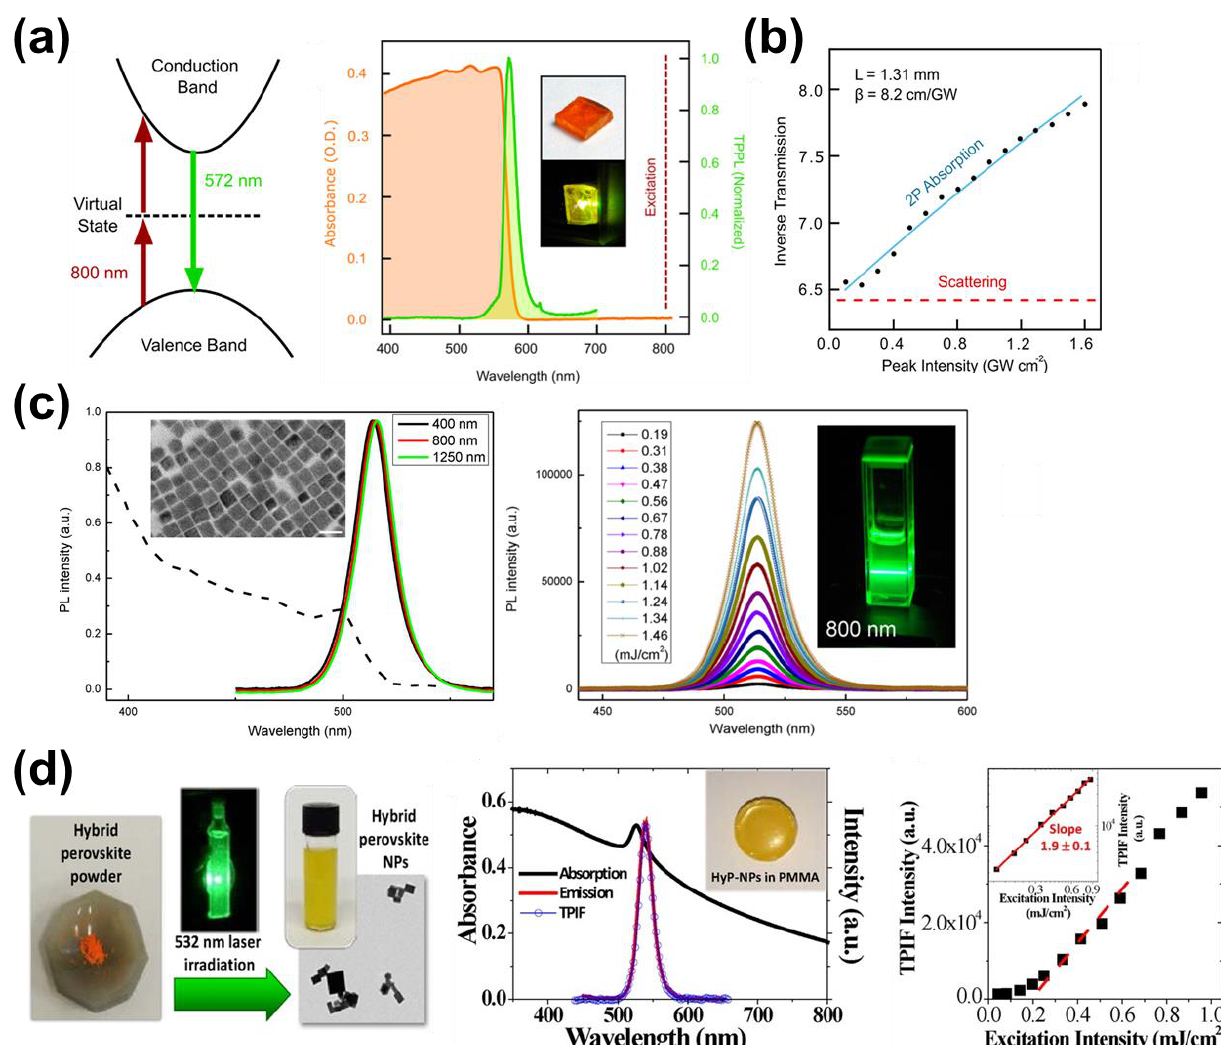
Figure 18. ( a ) Schematic showing two-photon absorption of 800 nm light and up-conversion to 572 nm photoluminescence and a linear optical absorbance and normalized two-photon-induced photoluminescence as a function of wavelength for a single MAPbBr 3 crystal. [96]. Copyright 2015 American Chemical Society. ( b ) The two-photon absorption coefficient of inverse transmission versus peak intensity. [96]. Copyright 2015 American Chemical Society. ( c ) The linear absorption spectrum and one-, two-, and three-photon excited PL spectra from the solution of CsPbBr 3 NCs and the excitation intensity-dependent PL showed the photograph of the resolution of CsPbBr 3 nanocrystals when an 800 nm laser beam passed through. [97]. Copyright 2015 American Chemical Society. ( d ) Schematic of perovskite NCs synthesis, schematic of optical absorption, PL and TPIF